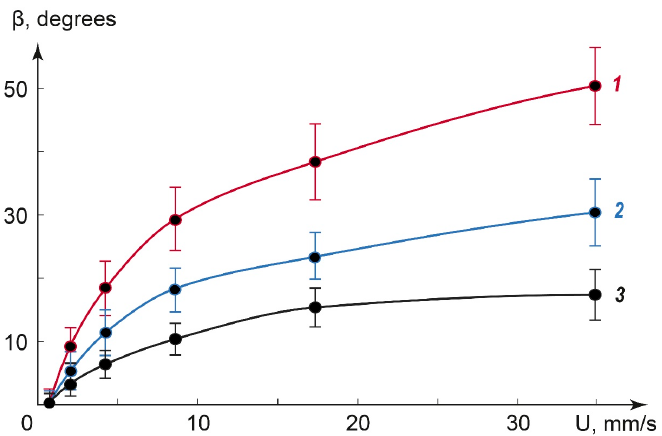
Figure 6. The impact of the flow velocity on the deformation angle β . Approximate droplet diame- ters: 60 μ m (1), 30 μ m (2), and 20 μ m (3). 60 µ m (1), 30 µ m (2), and 20 µ m